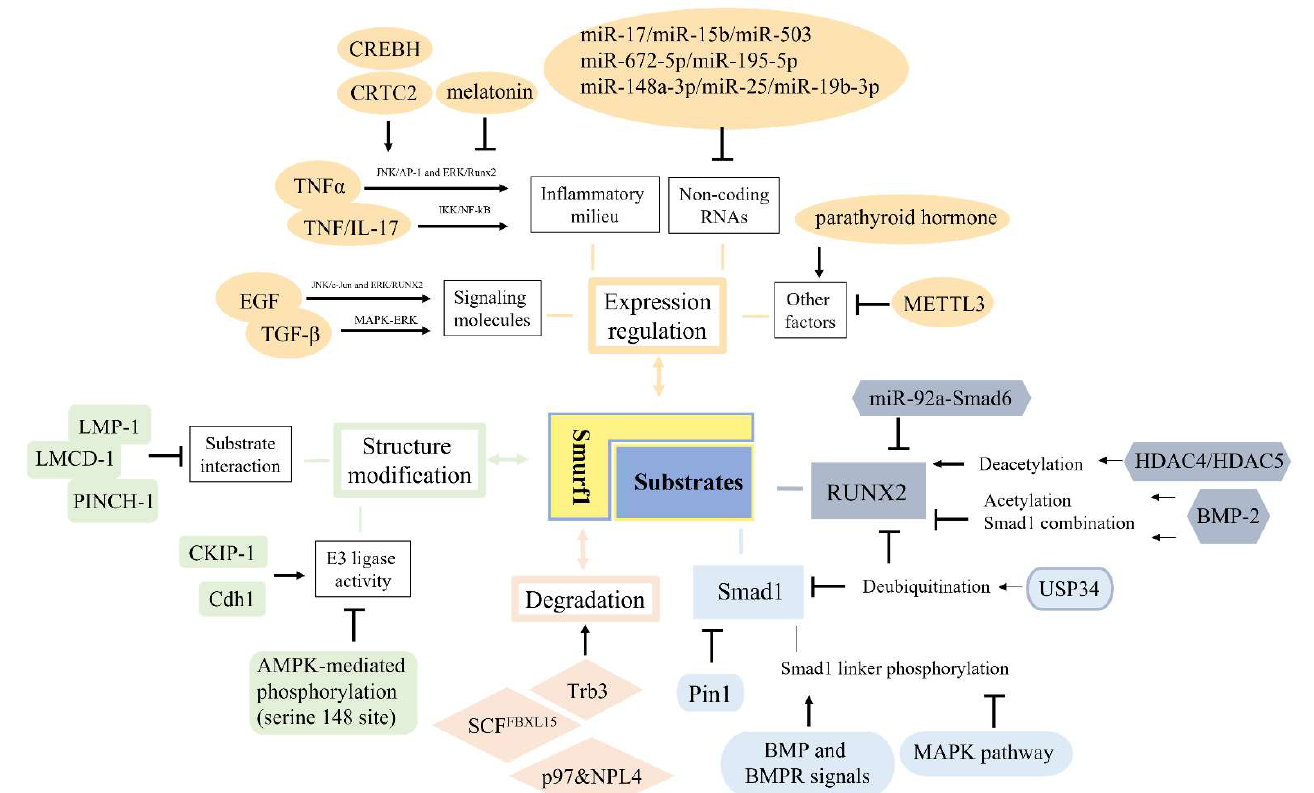
Figure 2. Smurf1–substrate interactions are regulated in many aspects. Smurf1 and its two common substrates, RUNX2 and Smad1, are respectively regulated. As for Smurf1, the upstream regulatory mechanisms are summarized as expression regulation, structure modification and induced degradation indicated by a double-headed arrow. Signaling molecules, inflammatory mediators, non-coding RNAs and other factors could increase or decrease Smurf1 expression. Several molecules can bind to Smurf1, thus inhibiting the interaction between Smurf1 and the substrates (LMP-1, LMCD-1, PINCH-1), or influencing its E3 ligase activity (CKIP-1, Cdh1, AMPK-mediated phosphorylation in serine 148 site). Trb3 dissociation, SCFFBXL 15 and p97-NPL4 complex can induce degradation of Smurf1. As for substrate modification, RUNX2 deacetylation by HDAC4/5 causes its degradation, but acetylation and Smad1 combination upon BMP2 stimulation, as well USP34-mediated deubiquitination and miR-92a-targeted Smad6 suppression can impede RUNX2 degradation. Smad1 linker phosphorylation can promote Smad1 ubiquitination degradation by Smurf1; however, Pin1 binding and USP34-mediated deubiquitination block its degradation and maintain its stability.